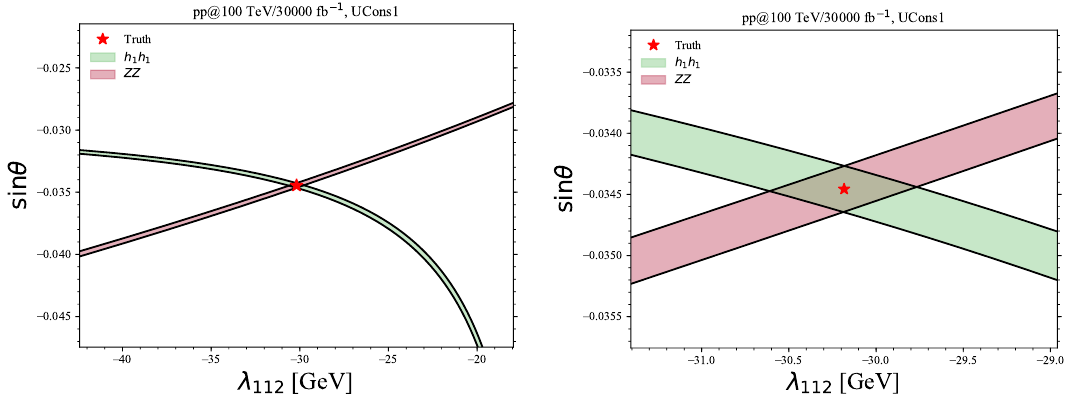
Figure 5 . An example of the fitting procedure for ( λ 112 , sin θ ) using the σ ( h 1 h 1 ) and σ ( ZZ ) bands as described in the text. The fit was again performed for the benchmark point “UCons1”. The red star represents the true values of sin θ ≈ − 0 . 034 , λ 30 . 183 GeV. The significances for this 112 ≈ − point in the h and ZZ final states from the analyses of ref. [54] was found to be Σ ( h ) ≈ 123 . 4 1 h 1 1 h 1 and Σ ( ZZ ) ≈ 53 . 0 standard deviations. This particular example was performed while keeping the mass fixed at the true value m = 377 . 5 GeV, for simplicity. The left plot shows an enlarged region 2 and the right plot is a zoomed-in